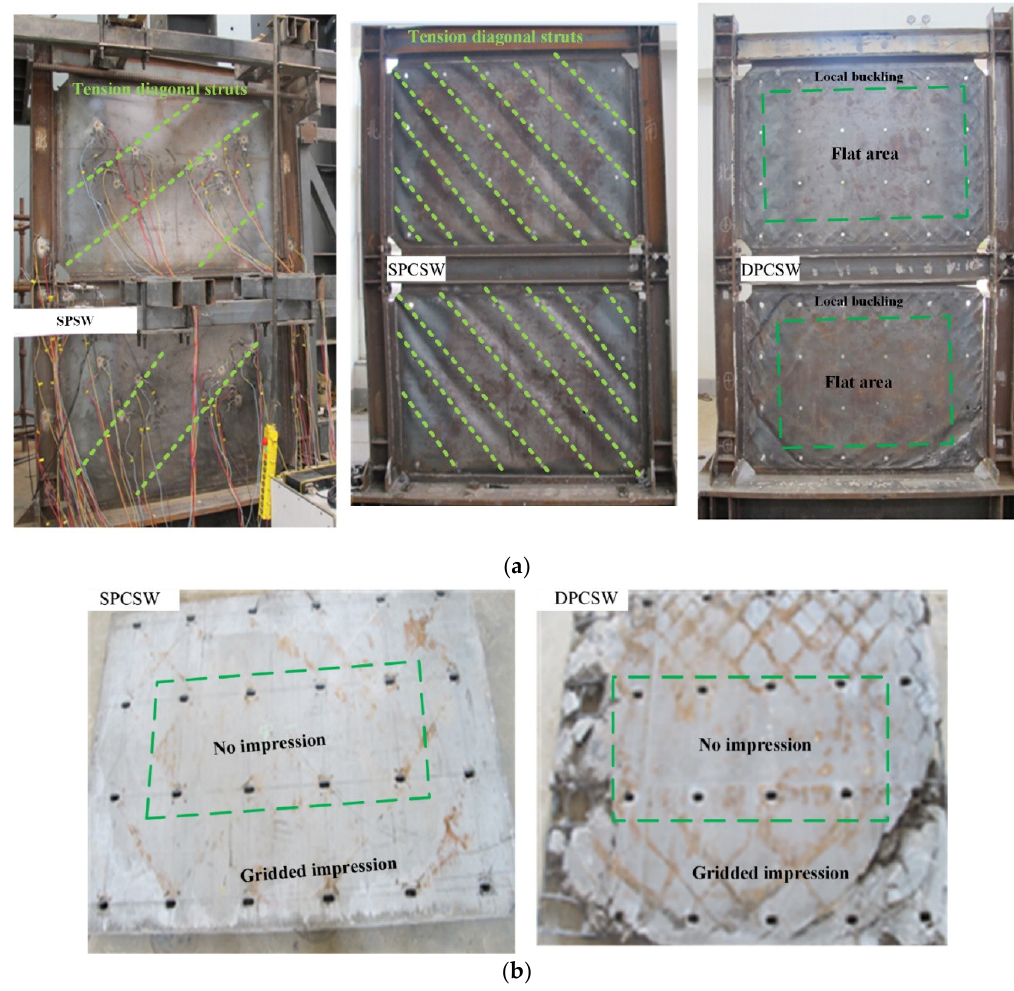
Figure 10. Failure mode of tested specimens: ( a ) performance of steel plates; ( b ) performance of prefabricated RC